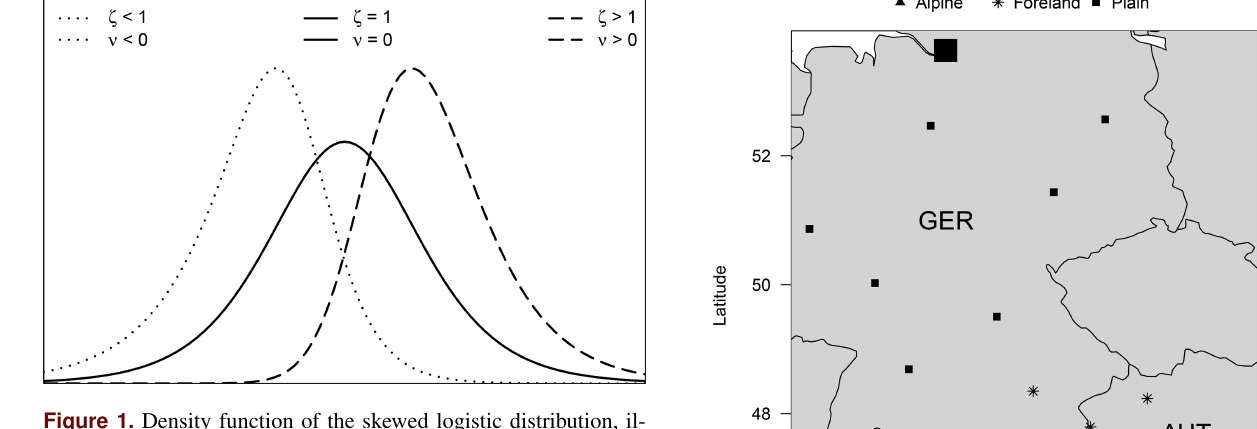
Figure 1. Density function of the skewed logistic distribution, il- lustrating the third moment ( ν , skewness) depending on the chosen shape parameter ζ .